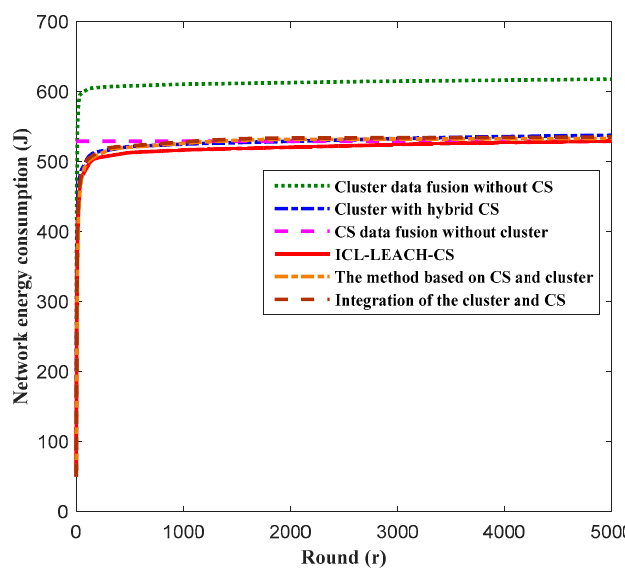
Figure 14. Network energy consumption vs. round.